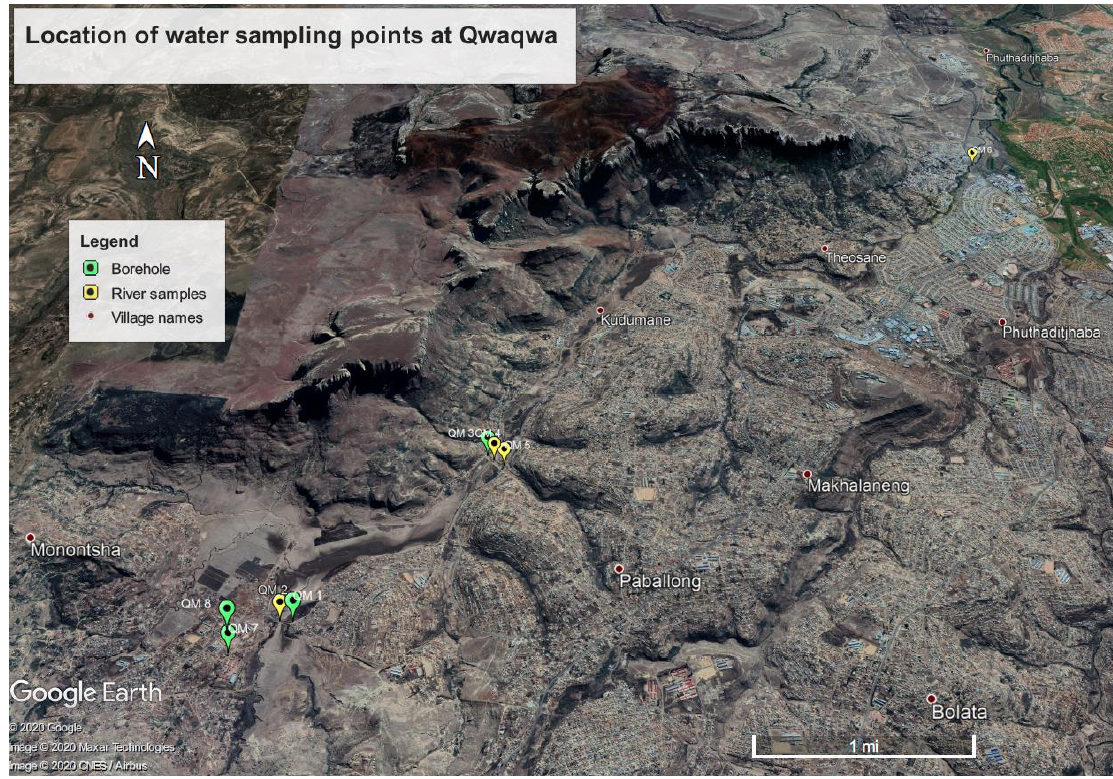
Figure 2 . Map showing sites for the sampled water sources. Figure 2. Map showing sites for the sampled water